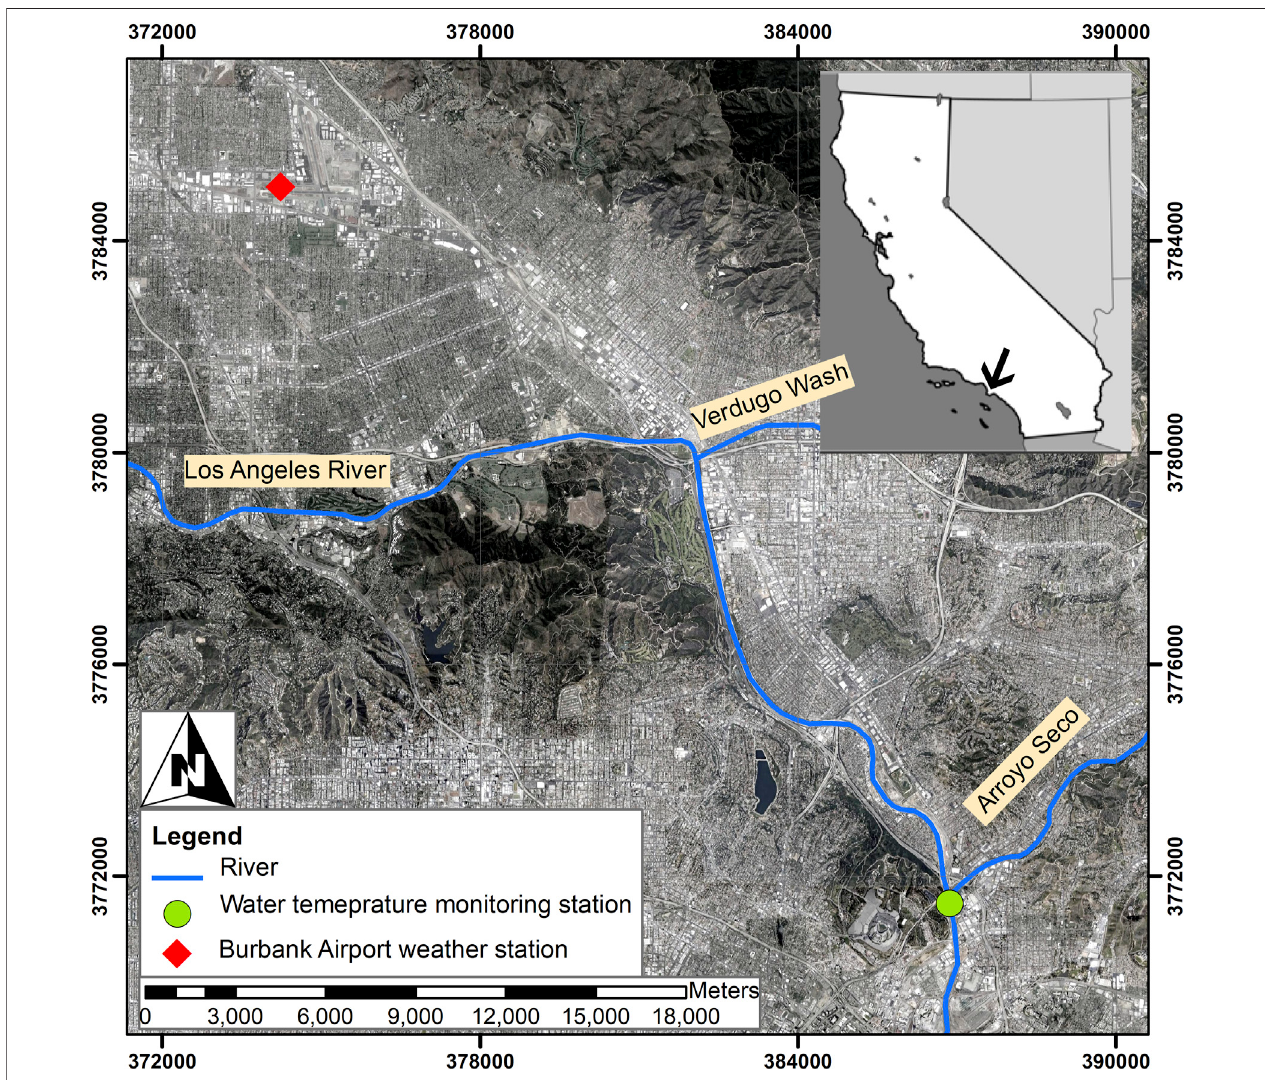
FIGURE 1 | The study area in Los Angeles (LA) River, CA, showing the temperature monitoring station on LA River downstream of the Arroyo Seco tributary and Burbank Airport weather station location. The inset with an arrow shows the site location within the state of California.